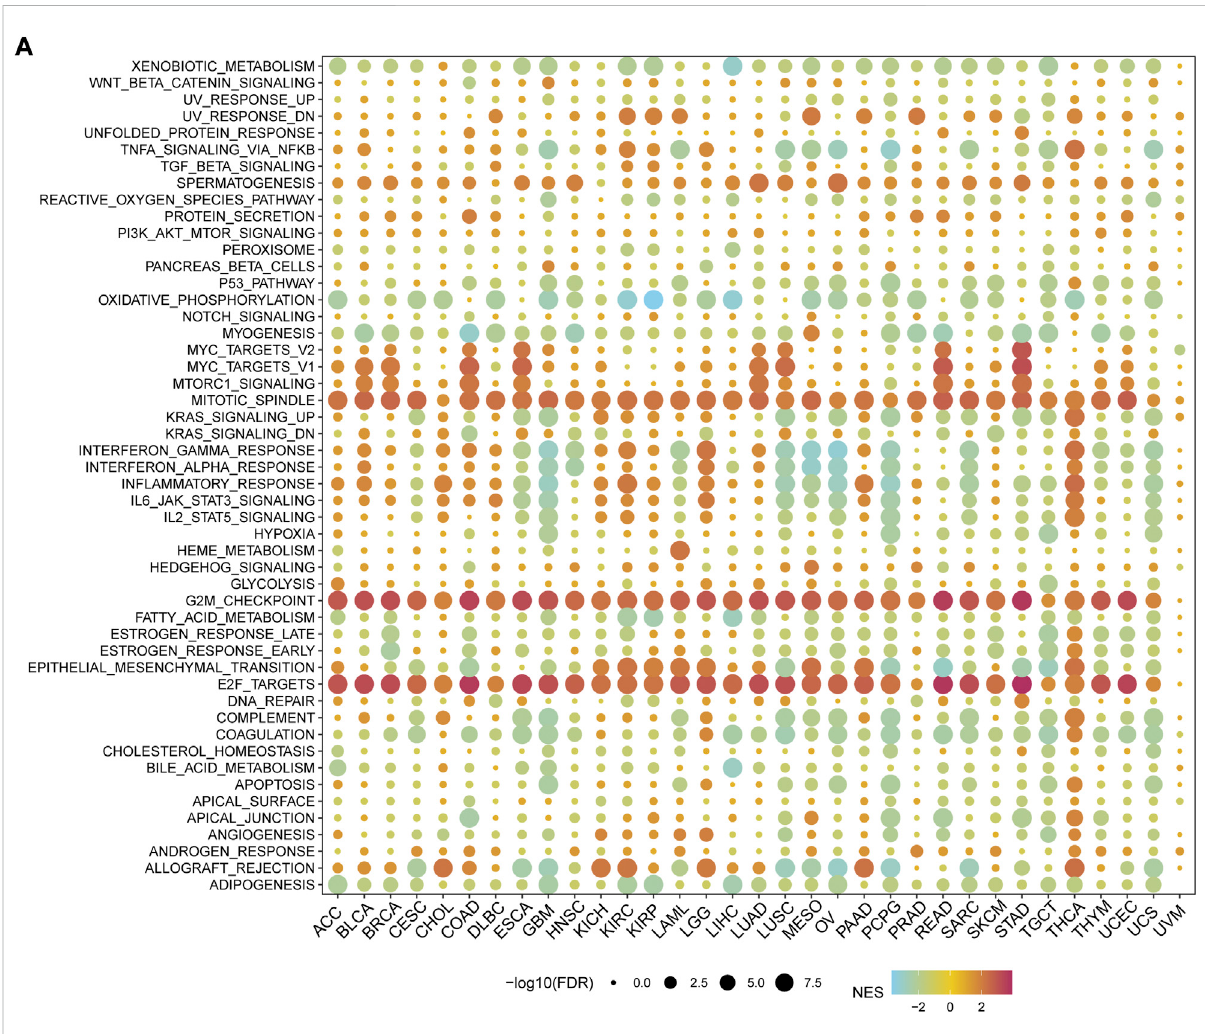
FIGURE 3 Functional analysis of methyl methanesulfonate-sensitivity protein 22-like (MMS22L) in pan-cancer. (A) Enrichment analysis for hallmark gene sets between high- and low- MMS22L expression